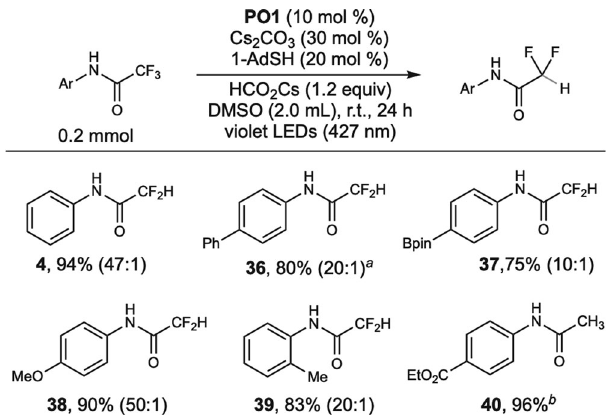
Fig. 5 Scope of hydrode fl uorination of tri fl uoroacetamides. Yields of isolated products. a PO5 (10 mol %), HCO 2 Cs (0.4 mmol). b HCO 2 Cs (0.8 mmol). The ratios of monohydrode fl uorination and dihydrode fl uorination are shown in parentheses.